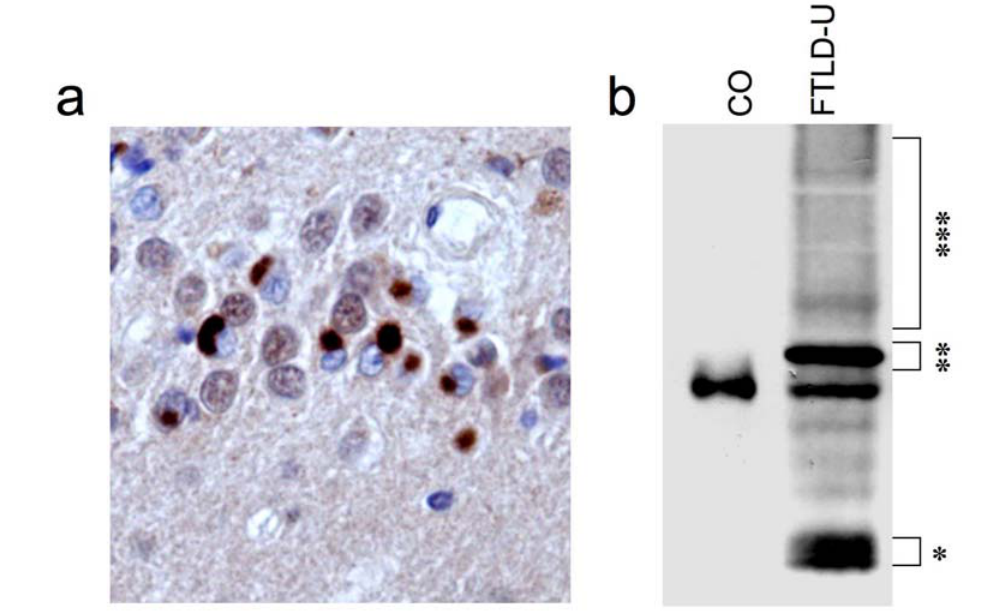
Figure 1. Neuropathology and biochemical alterations of TDP-43 in TDP-43-positive FTLD-U